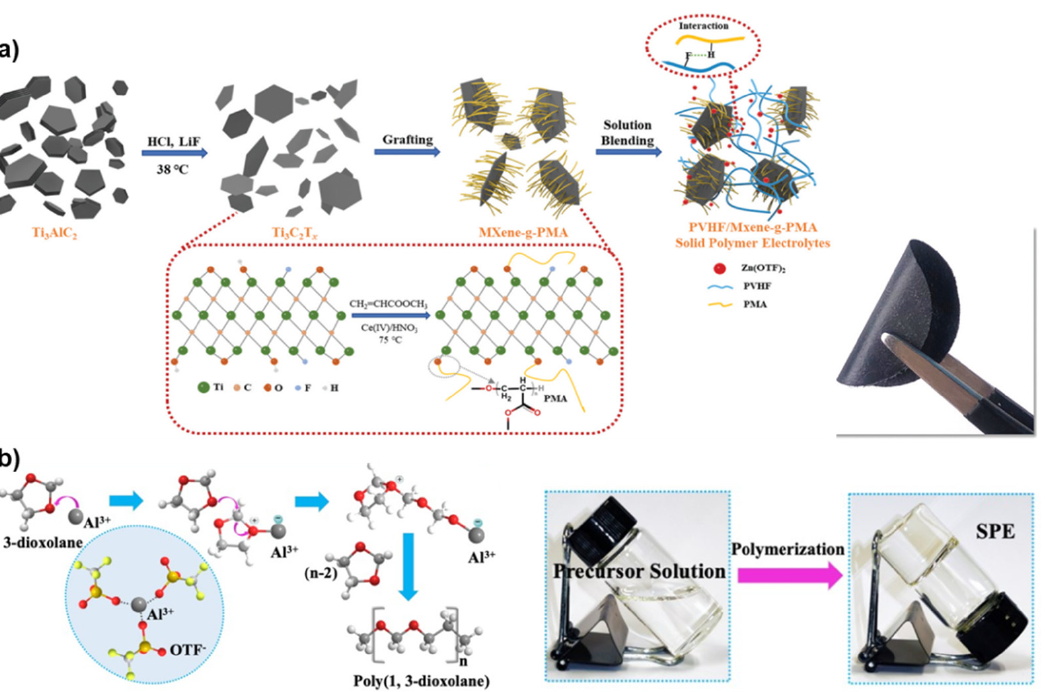
Figure 6. ( a ) Schematic fabrication of the solid state MXene- g -PMA electrolyte. Reproduced with permission from [59]. ( b ) The reaction mechanism of the 1,3-dioxolane based solid polymer electrolytes. Reproduced with permission from [60].